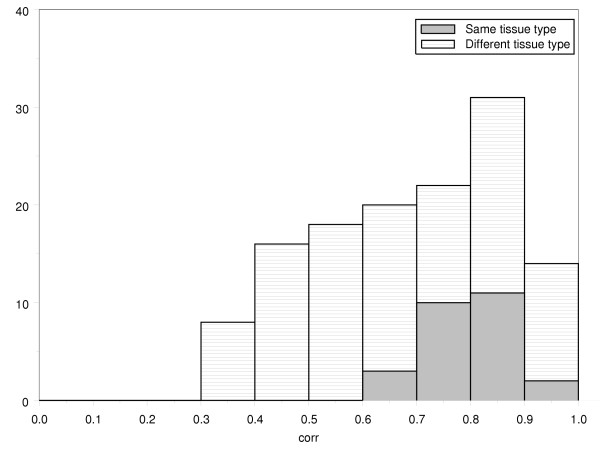
Histograms of the correlation coefficient between two libraries, as estimated with the bivariate model. Library pairs of identical tissue type compared to libraries of different tissue type.